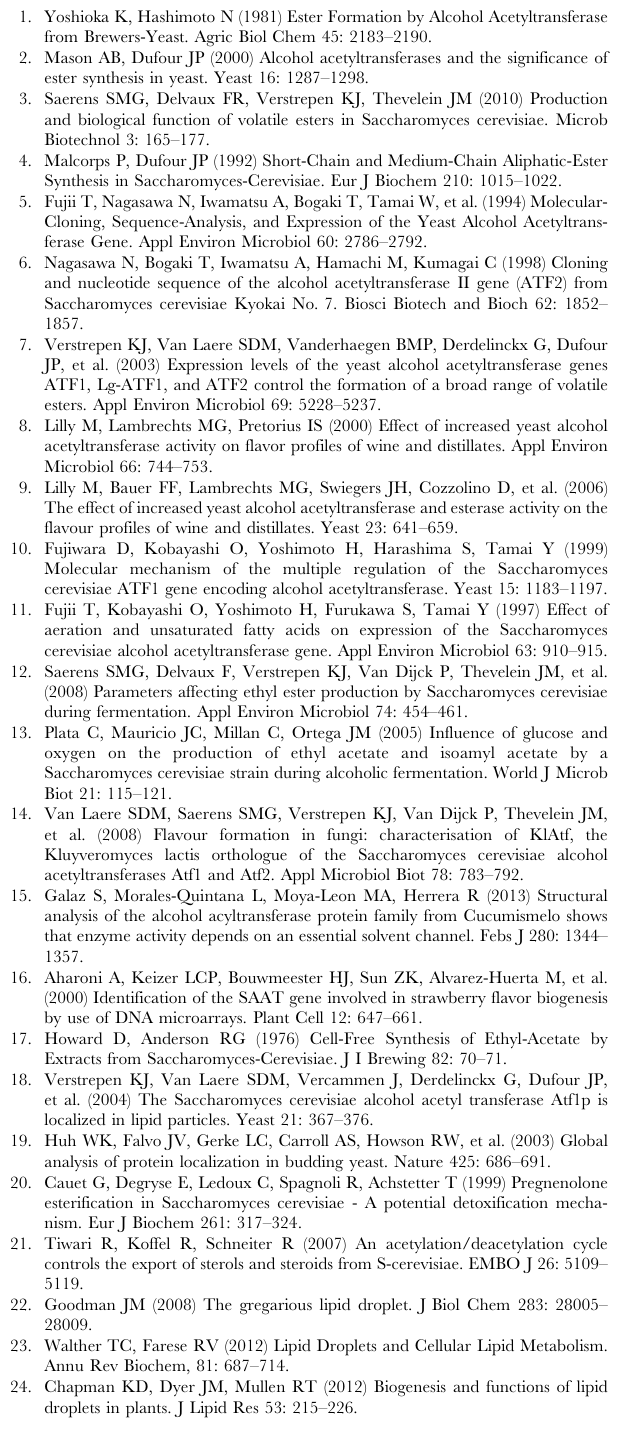
Figure S3 Time course study of cellular localization of Atf1, Atf2, and their mutants. Cells were first grown to stationary phase followed by dilution in fresh media (t= 0 hrs.). Cells were harvested and analyzed at different time points (t= 4, 10, 18, and 24 hrs.). Nascent and premature LDs are indicated by white